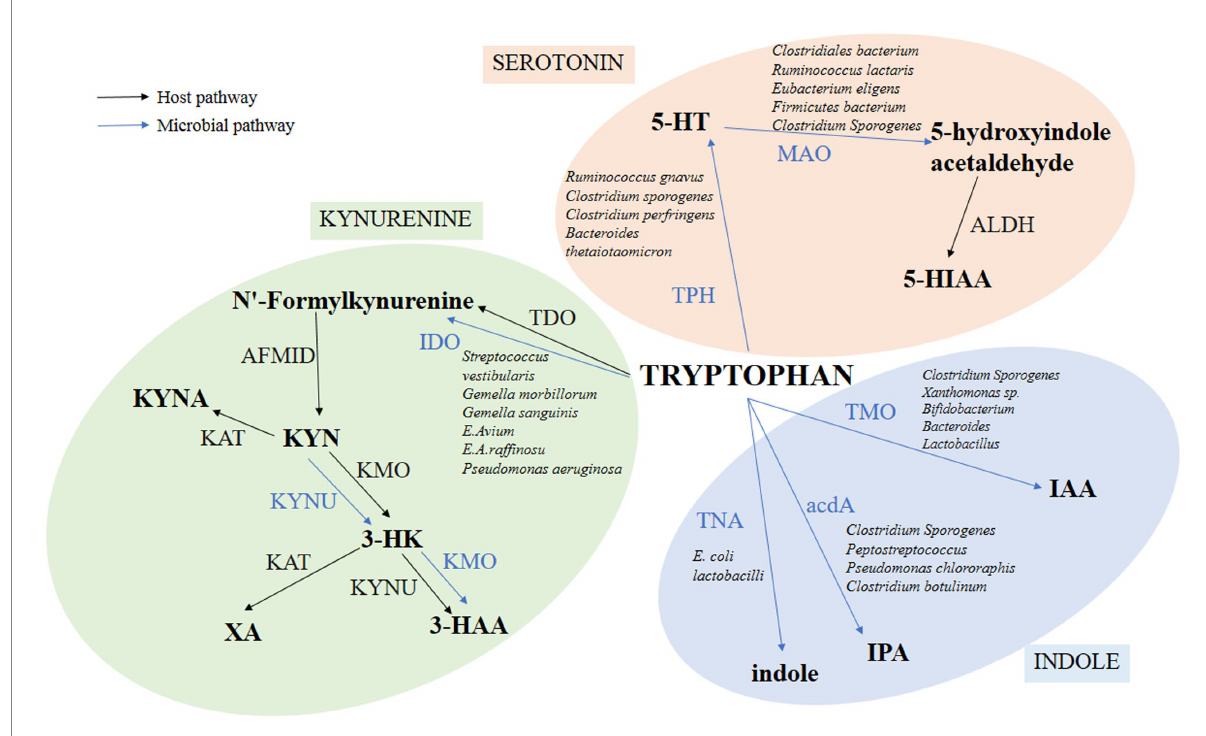
FIGURE 1 Pathways of TRP metabolism through 5-HT, KYN, and indole. The figure shows only the major metabolic processes and products, omitting some intermediate processes. Among them, the intestinal microbiota directly converts TRP into many kinds of bioactive molecules to execute multifold functions for intestine health. Blue lines indicate pathways for TRP metabolite in bacteria. Black lines indicate the TRP metabolite pathways in the